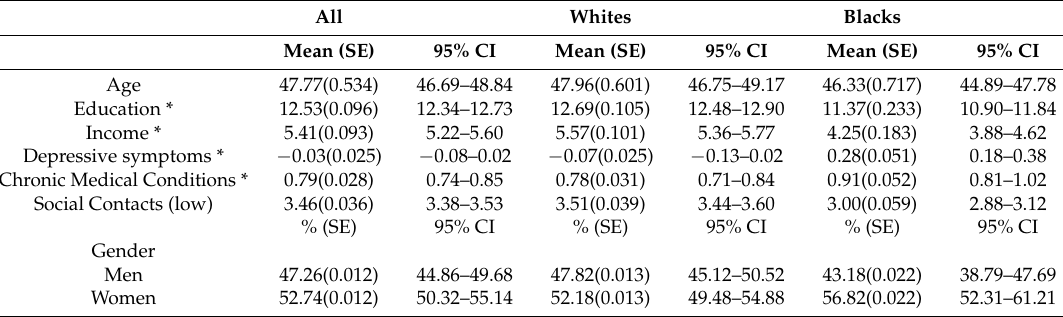
Table 1. Descriptive Statistics in the pooled sample and stratified by race.